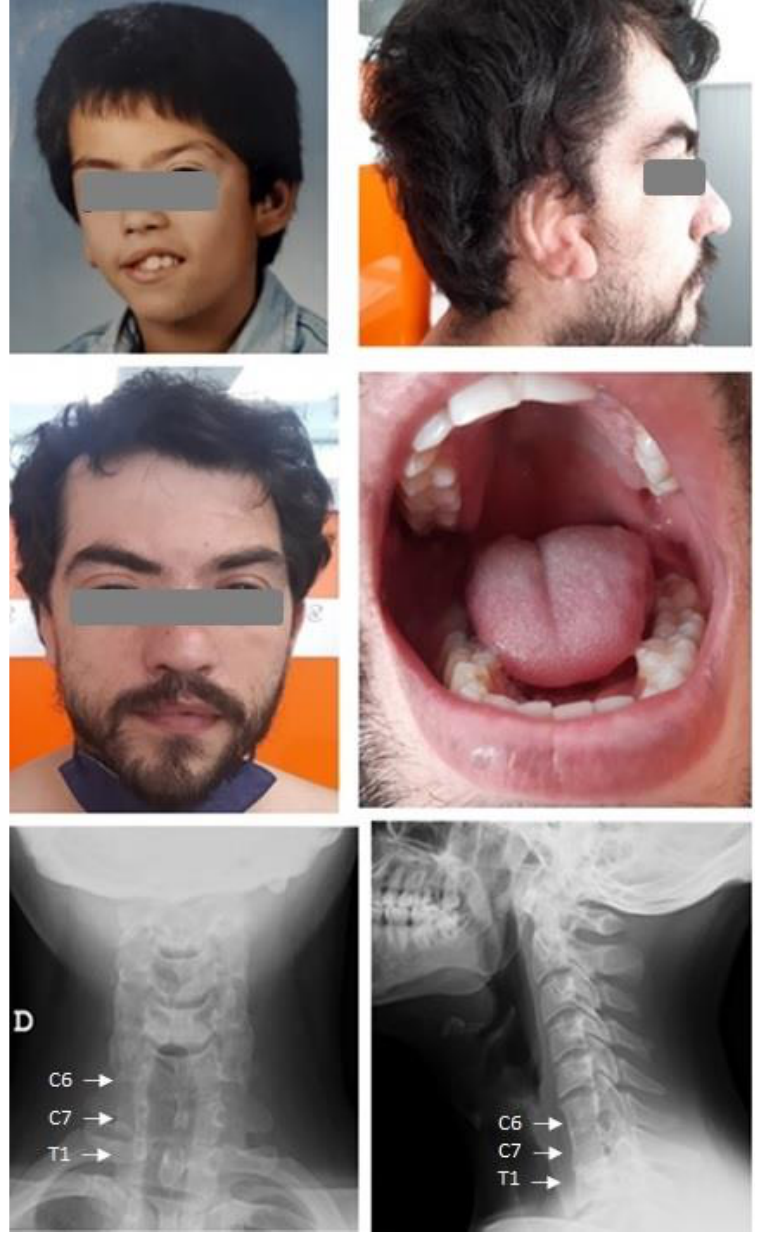
Figure 1. The patient’s pictures show ptosis, thick eyebrows, mild right face hypoplasia, bulbous nose, right hemilingual hypoplasia, and reconstructed ear in childhood (upper left) and adulthood. X-rays show C6-C7-T1 fusion.